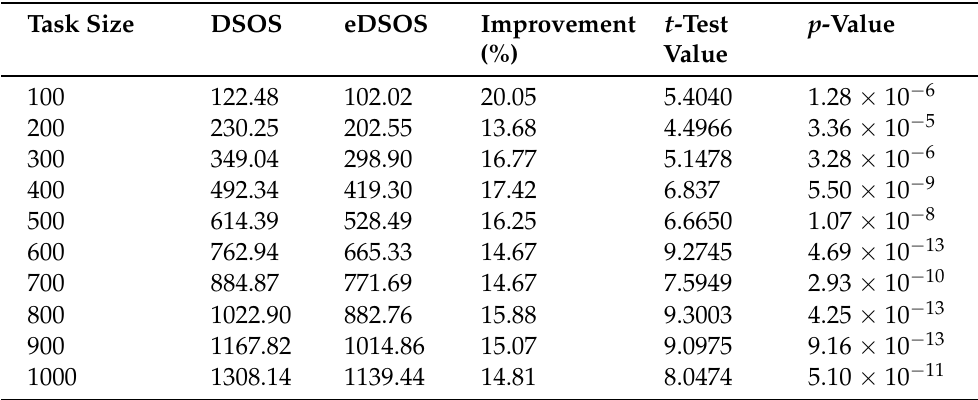
Figure 13. The convergence curves with 1000 instances of tasks. Table 5. Comparison of the makespans of DSOS and eDSOS for the normally distributed dataset.